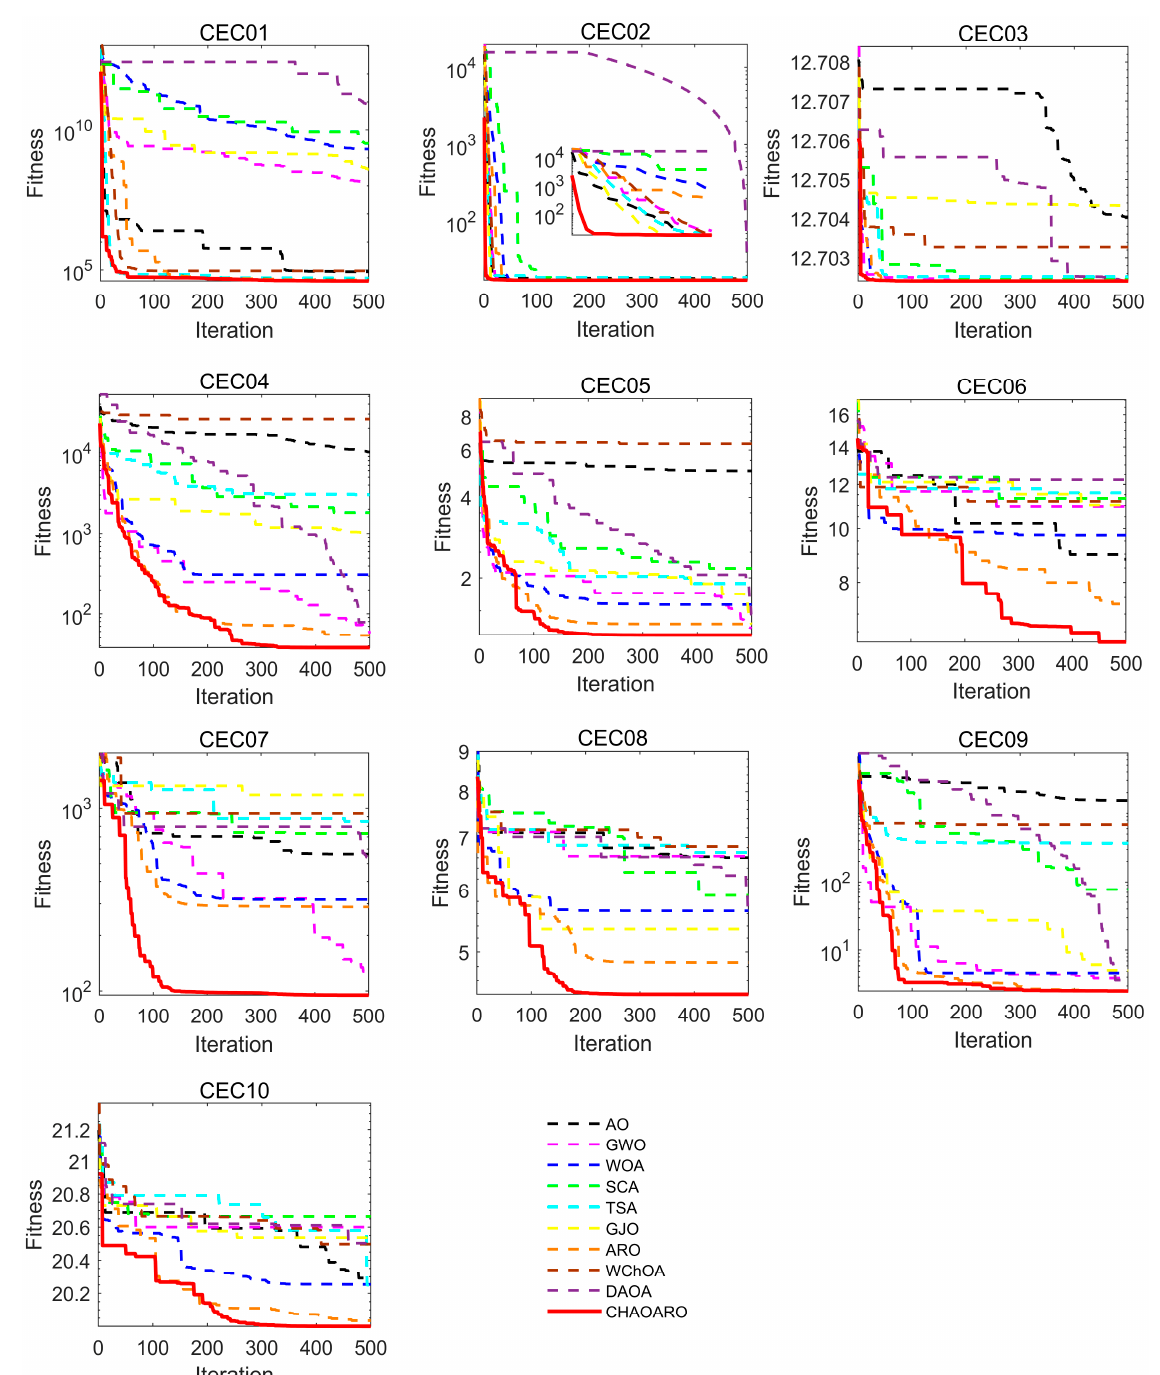
Figure 10. Convergence curves of CHAOARO and other comparison algorithms on 10 CEC2019 test functions.